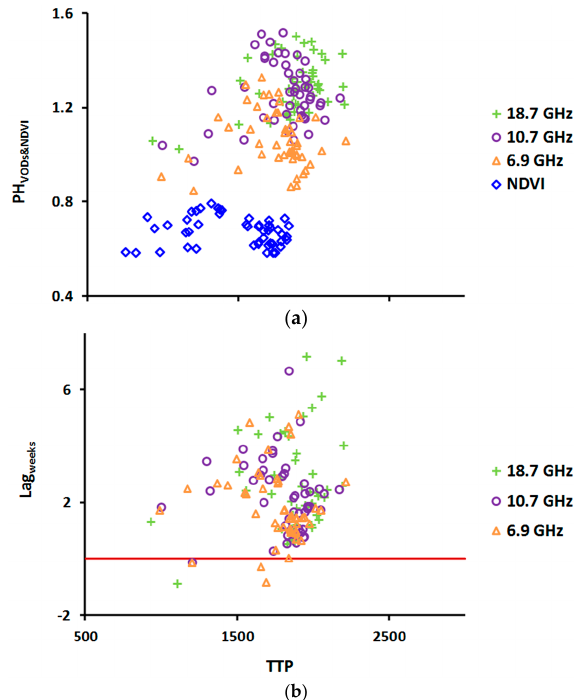
Figure 12. Scatterplots of: ( a ) the PH VOD determined by maximum value and the PH NDVI from the CxQ model as a function of their corresponding TTP; and ( b ) PH VOD lags relative to their corresponding PH NDVI as a function of the respective TTP VODs. Details can be found in Table A1.